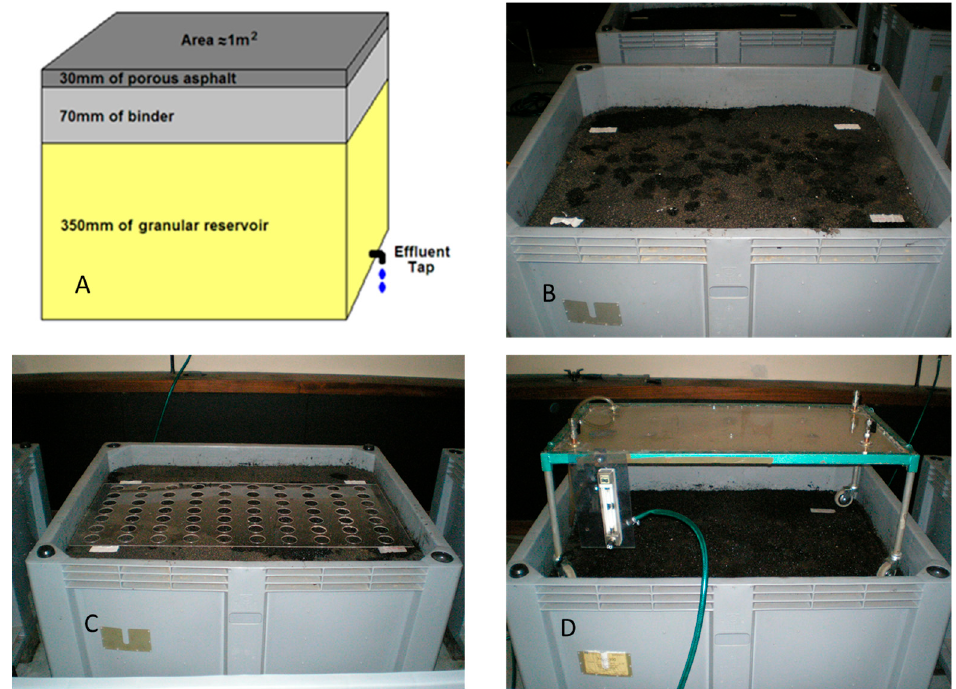
Figure 1. ( A ) Structure of the test rig; ( B ) surface course during monitoring; ( C ) Perspex quadrat in place; ( D ) rainfall simulator used during monitoring.